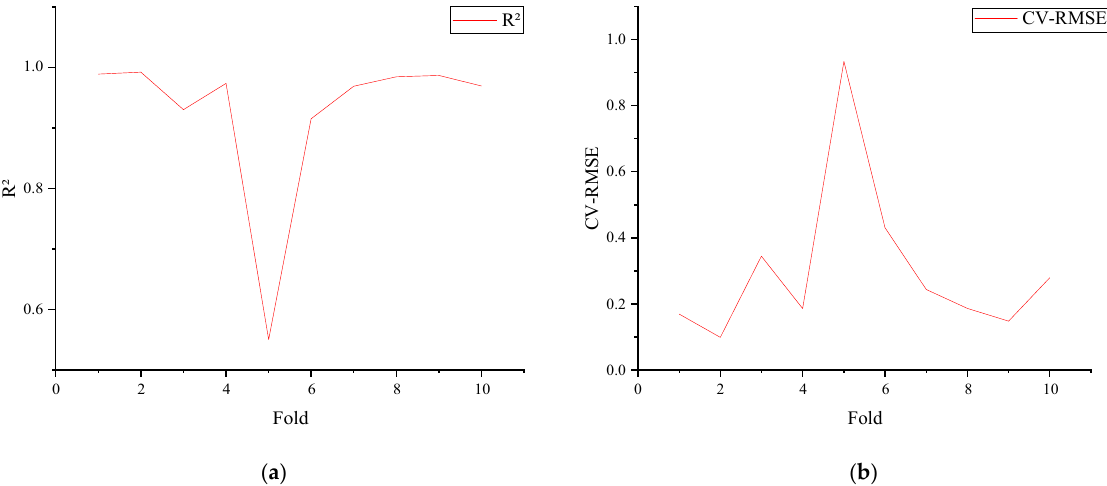
Figure 5. Accuracy index of the Gaussian process regression model with ten-fold cross-validation (using initial data) . ( a ) R 2 . ( b ) CV-RMSE.